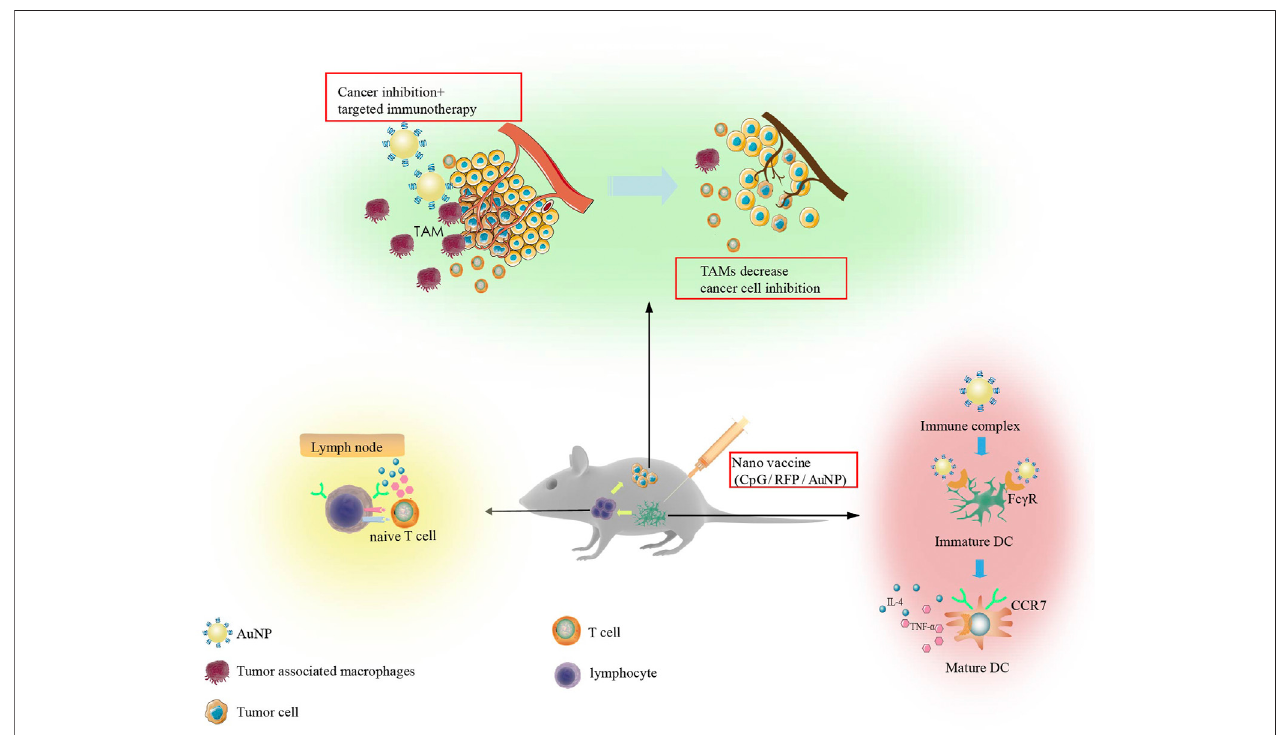
FIGURE6| Immunotherapystrategydesignedonthebasisof invitro studies.ThesynthesizedNanovaccinecanregulatedendriticcells,enhancetheirmigrationto lymph nodes, and result in T cell activation. This ultimately reduces M2 tumor associated macrophages producing ef fi cient anti-tumor immunity.